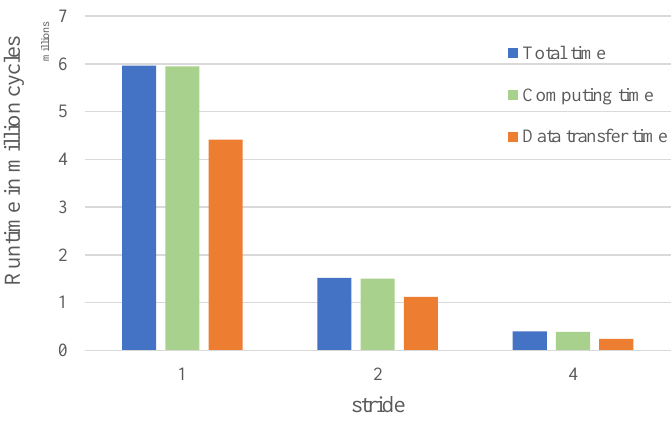
Figure 12. The time cost of convolution under different